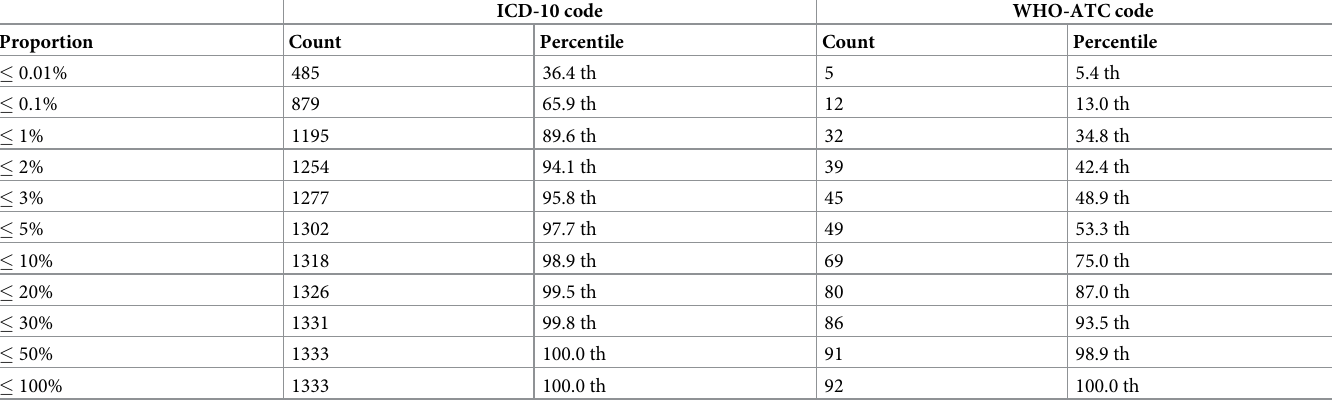
Table 3. Cumulative distribution of the proportion of enrollees whose claims contain the ICD-10/WHO-ATC code at least once in the study population (N = 631,731). ICD-10 code WHO-ATC code